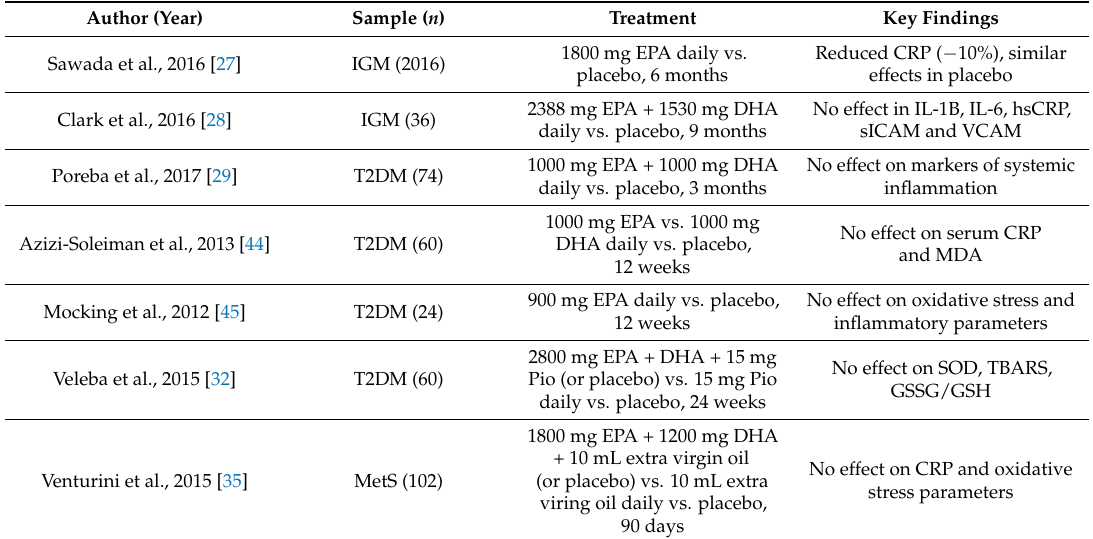
Table 4. Inflammation and oxidative stress in in diabetes and metabolic